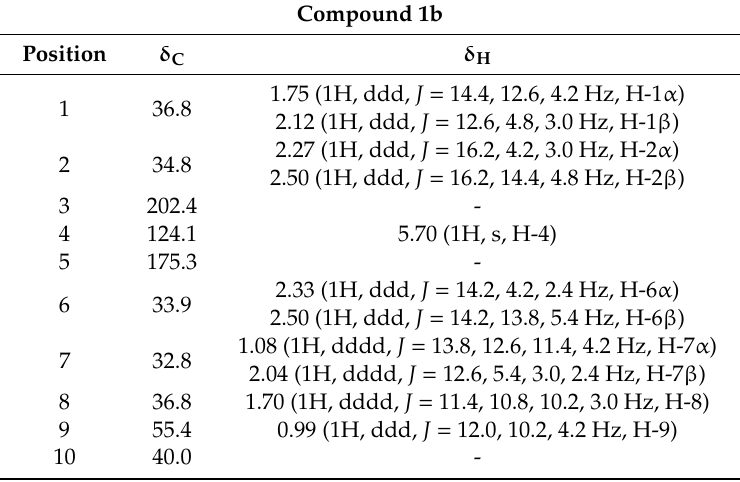
Table 2. NMR spectroscopic data for compound 1b (T-17-GG) in CD 3 OD ( δ in ppm, J in